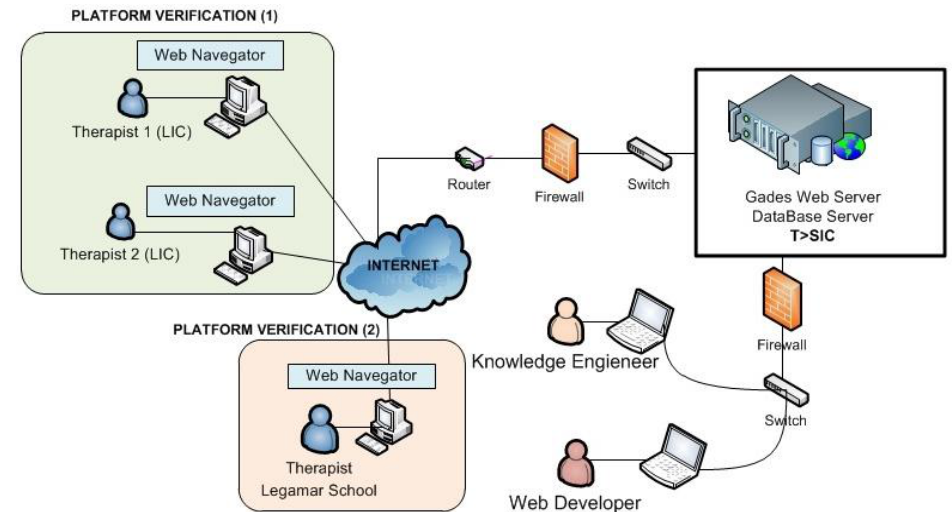
Figure 7. Gades web tool deployment.